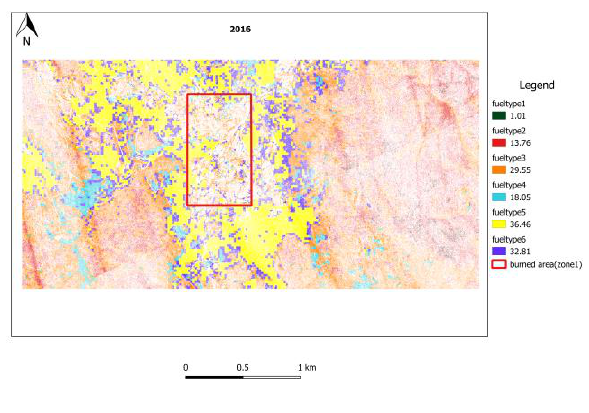
Figure 7a. Fuels classified by Prometheus model in 2009.